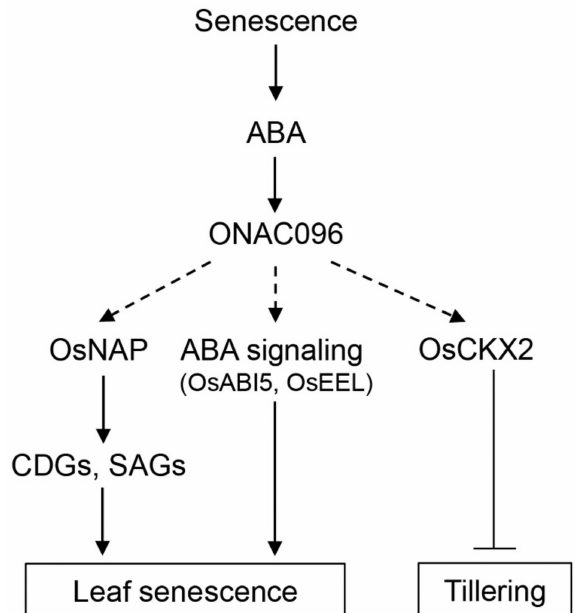
Figure 8. Proposed model of the role of ONAC096 in leaf senescence and tillering in rice. Arrows indicate upregulation, and lines ending with bars represent downregulation. Solid and dashed lines represent direct and indirect regulation of downstream genes,